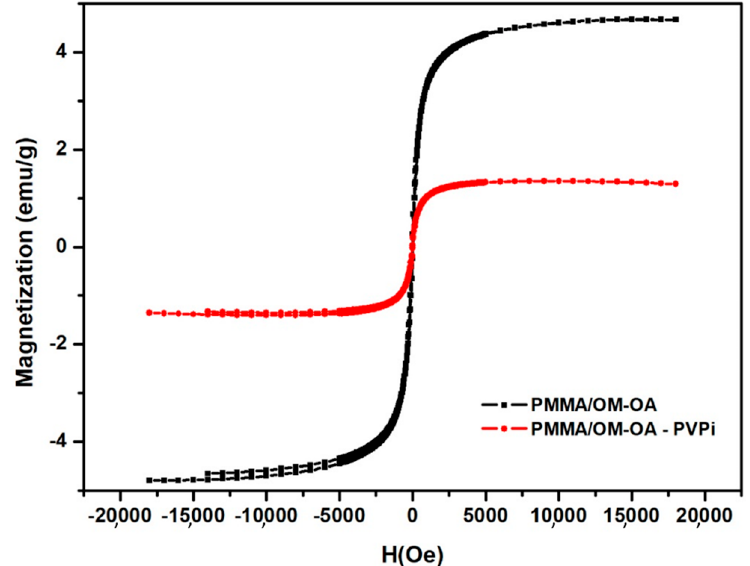
Figure 8. Magnetization curves as a function of the magnetic field applied to the ambient temperature of the PMMA/OM-OA and PMMA/OM-OA/PVPi samples.